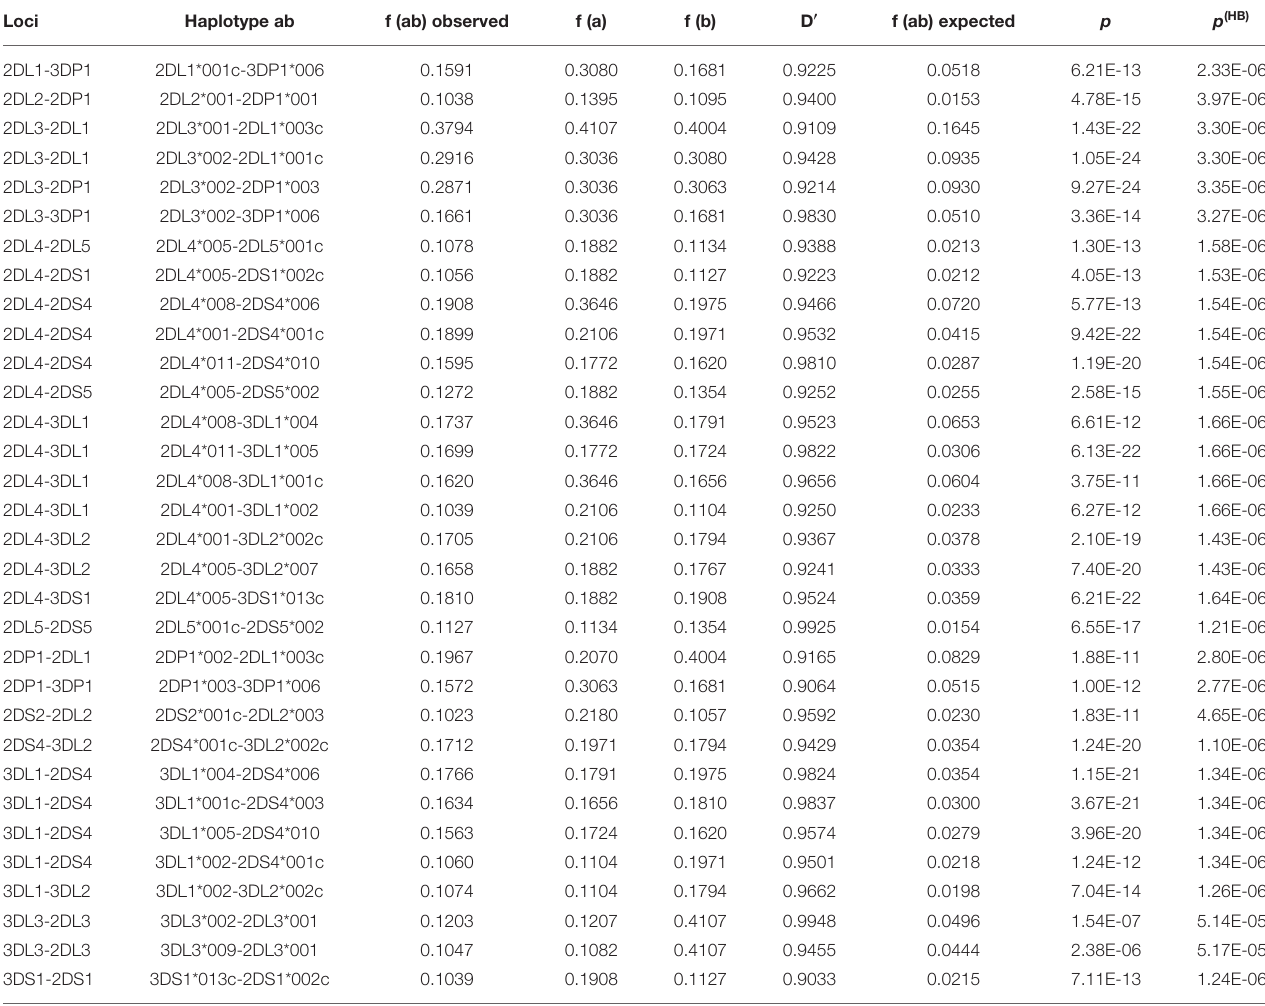
TABLE 3 | 2-locus linkage